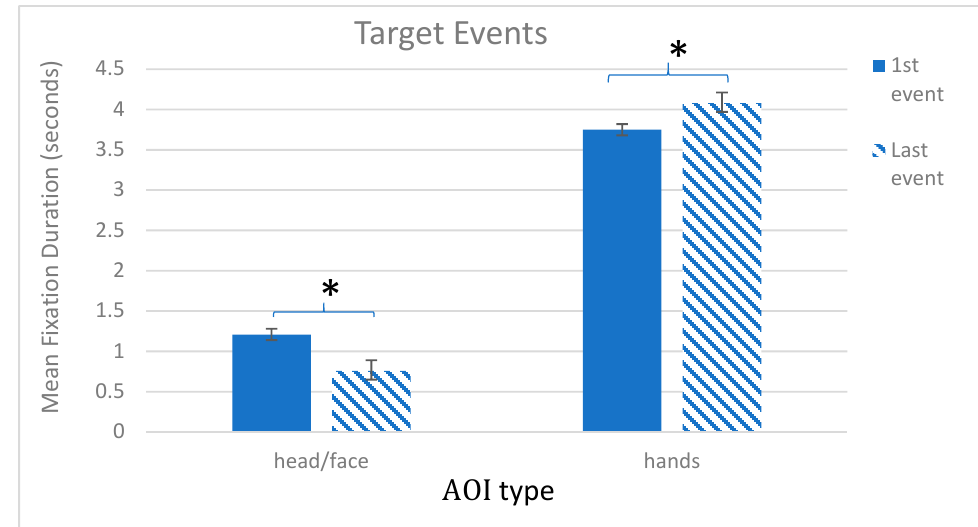
Figure 4. Target Events. Graph shows mean total fixation duration by trial (first, last) and AOI type (head/face, hands), * p < 0.05.